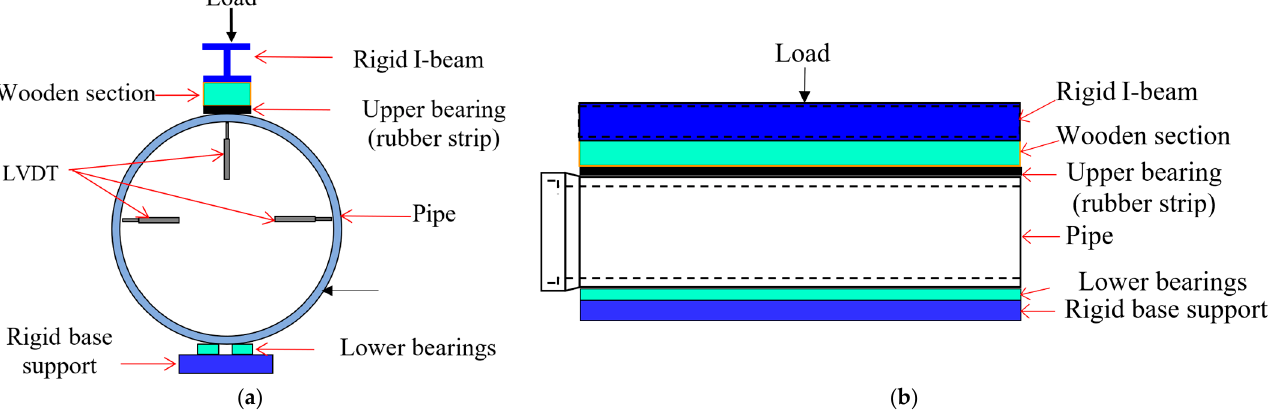
Figure 16. Schematic of three ‐ edge bearing test: ( a ) cross ‐ sectional view, ( b ) longitudinal view. Table 6. Results of three ‐ edge bearing tests.